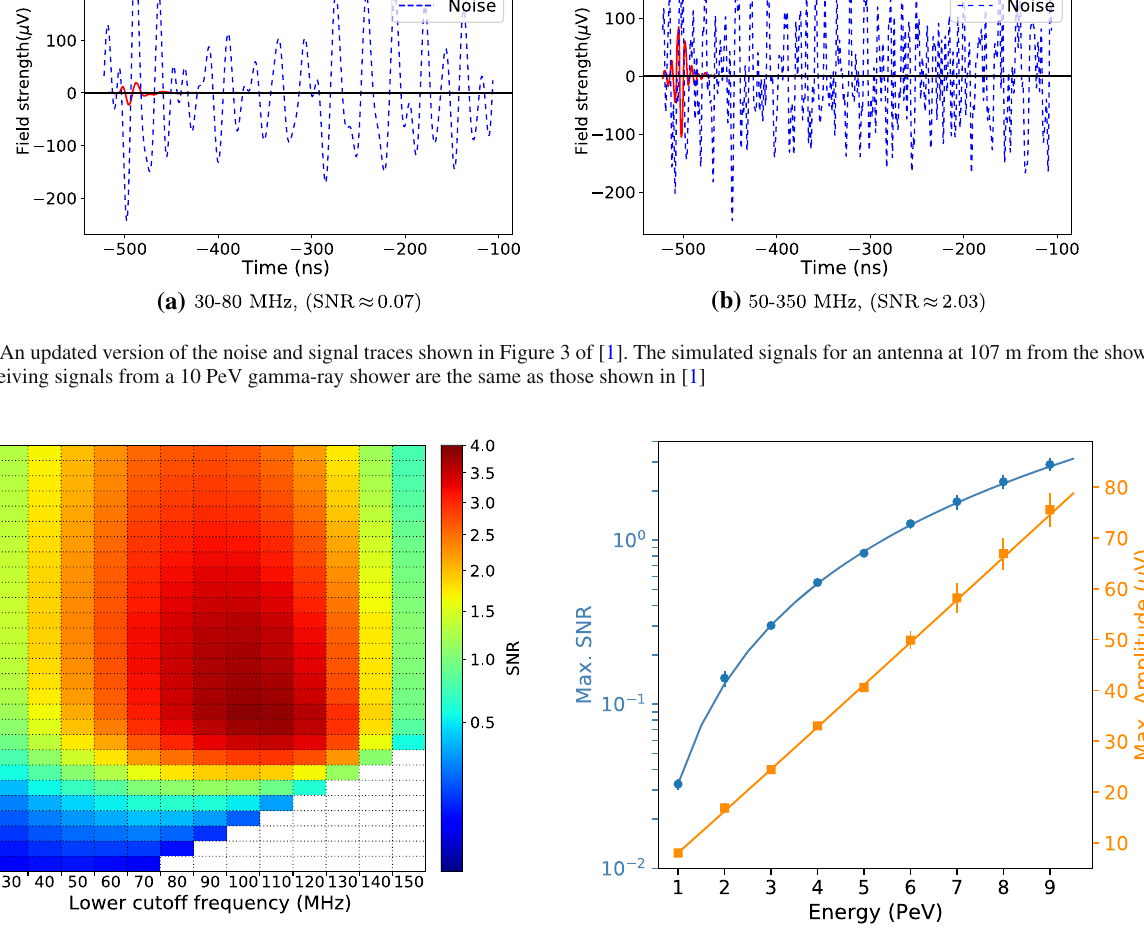
be determined by a dedicated study for this higher energy